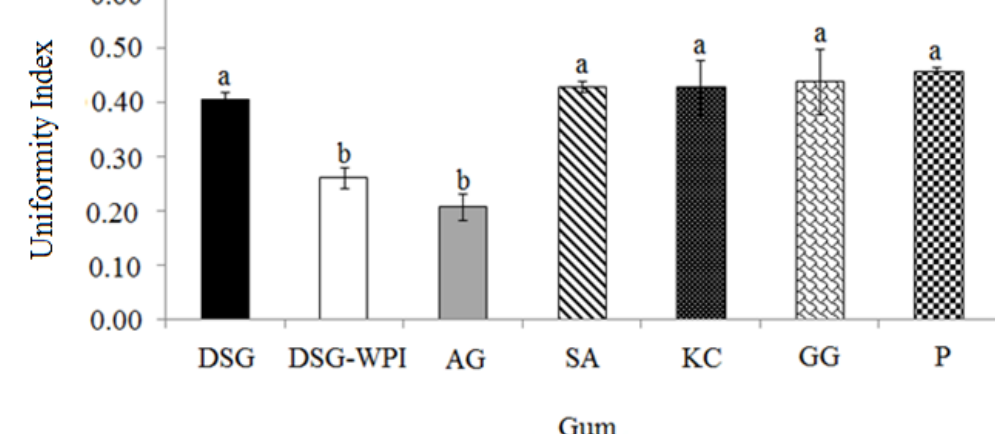
Figure 4. Particle uniformity of the non-conjugated durian seed gum (DSG) and conjugated durian seed gum (DSG-WPI) as compared to other commercial gums ( i.e. , Arabic gum (AG), sodium alginate (SA), kappa carrageenan (KC), guar gum (GG), and pectin (P); a , b : significant different at p <